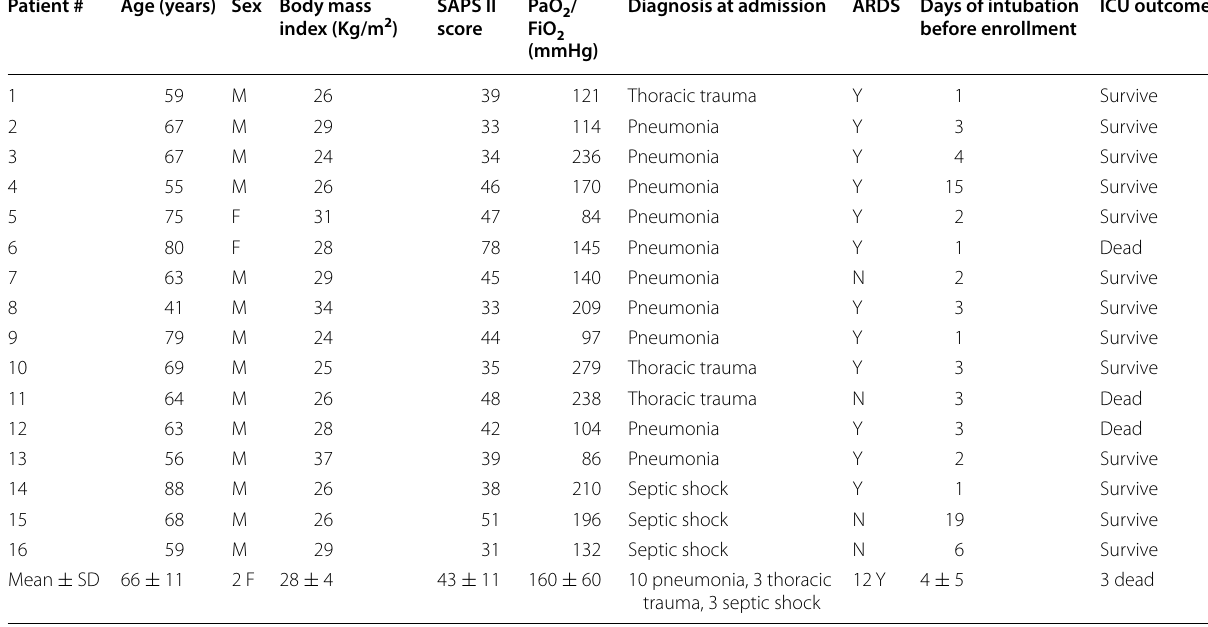
SAPS, Simplified Acute Physiologic Score; ARDS, acute respiratory distress syndrome; ICU, intensive care unit